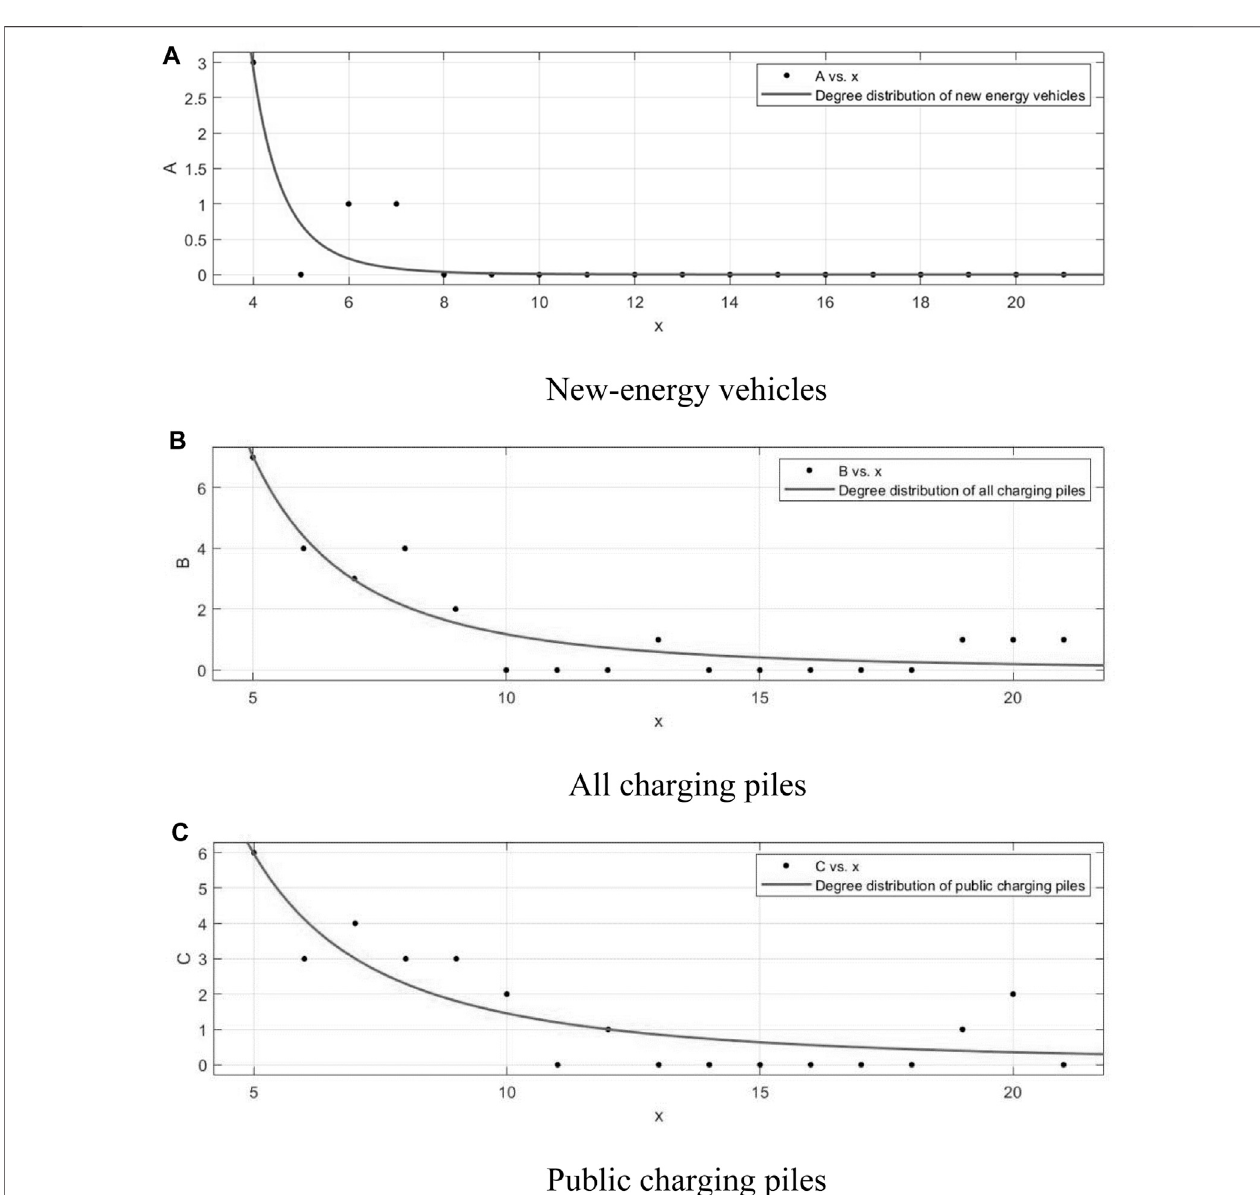
FIGURE 6 | Degree distributions of new-energy vehicles, all charging piles, and public charging piles.